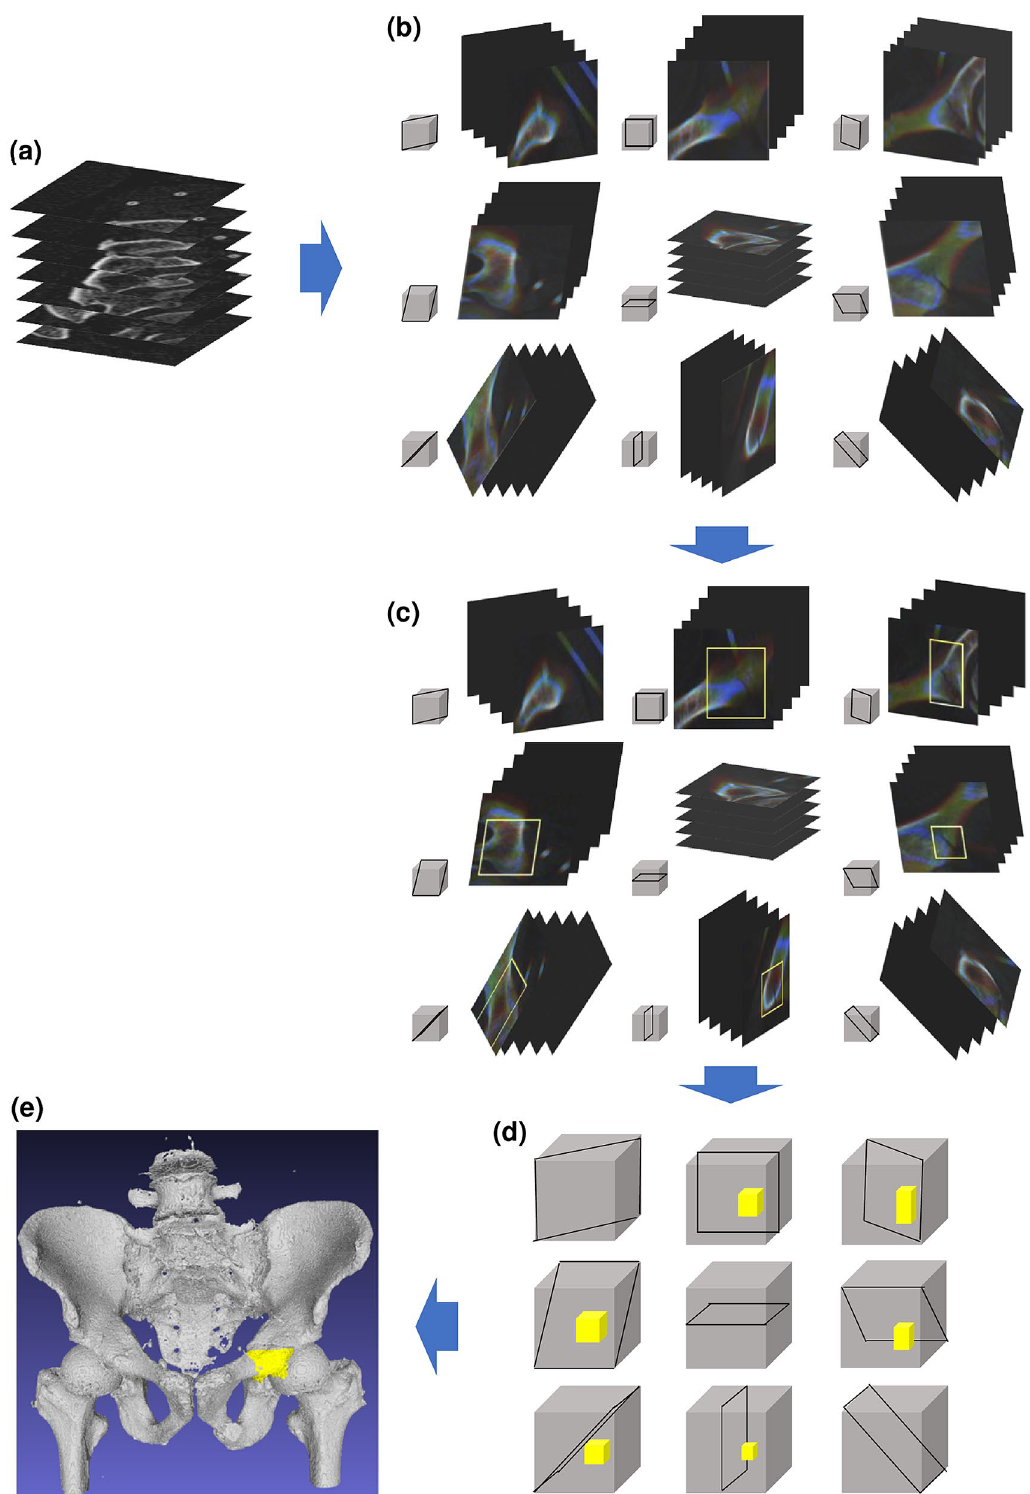
Figure 1. Conceptual diagram of the proposed method. ( a ) A series of axial CT images obtained from a subject. Each image represents 50 × 50-mm area for easy understanding. ( b ) Nine synthesized, orientated 2.5D images. Three slab images with thicknesses of 18.6 mm, 9.0 mm, and 0.6 mm are visualized by R-G-B colors, respectively. ( c ) Detection of 2D fracture candidates. ( d ) Thickening of 2D fracture candidates. ( e ) Fracture region